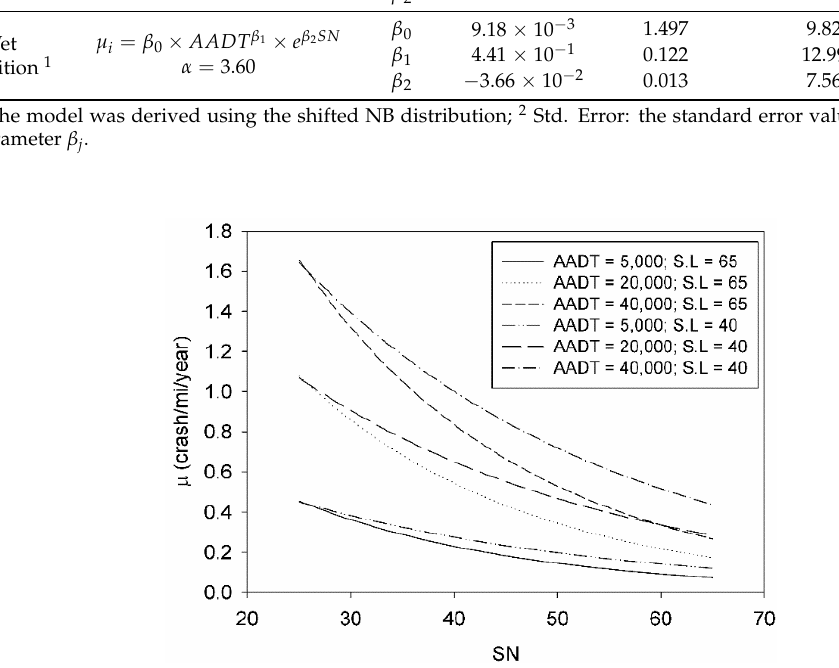
Figure 6. Expected crash rates as a function of SN, AADT, and SL; as explained by the NB regression models.